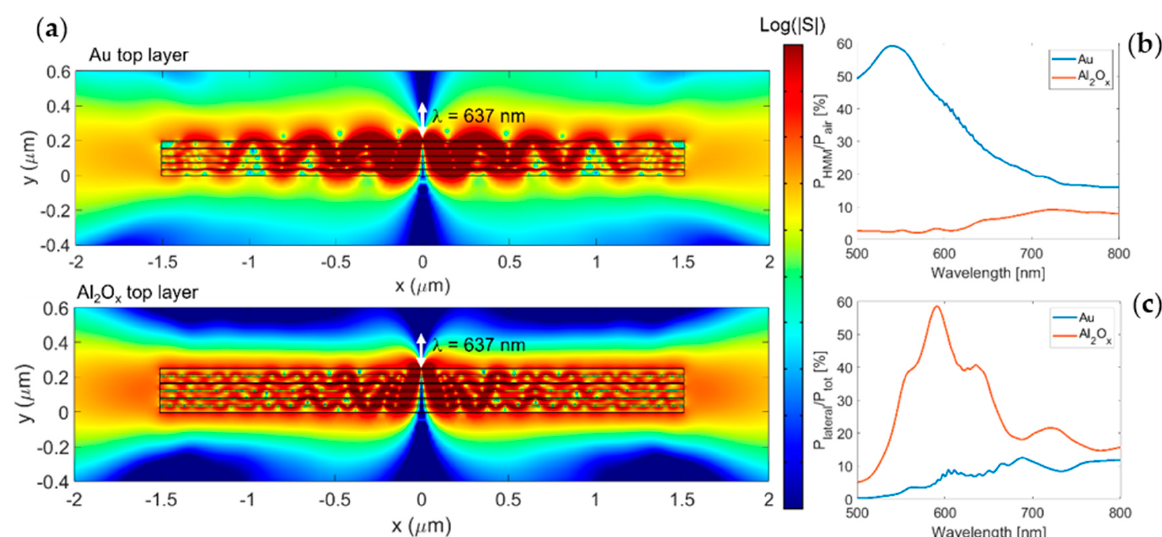
Figure 4. ( a ) Magnitude of Poynting vector (on a logarithmic scale) of the field radiated by a dipolar source (white arrow) vertically oriented placed 5 nm above the MM surface plotted respectively for the ENZ metamaterial with the Au top layer (top) and Al 2 O x top layer (bottom). ( b ) The Purcell factor at different wavelengths was calculated for the Au top layer (blue line) and the Al 2 O x top layer (red line) configurations. ( c ) The percentage of lateral emitted power with respect to the total power is reported for the Au (blue) and Al 2 O x (red) top layer configurations.